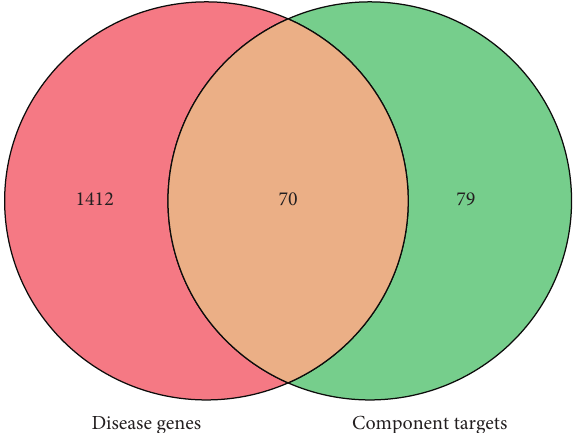
Figure 2: Potential therapeutic targets of Salvia miltiorrhiza for traumatic bone defects.